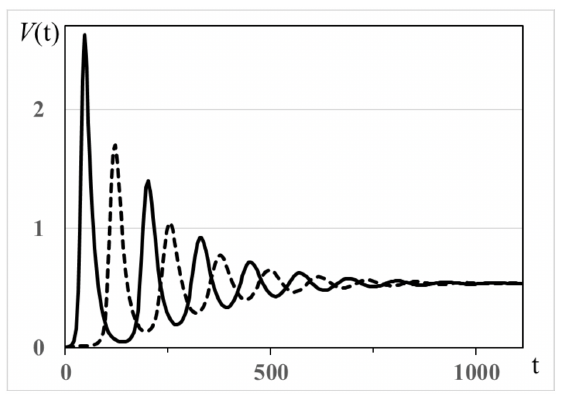
Fig. 10. Graphs of V ( t ) for oscillating dynamics for 2 different initial values ϕ ( a ) .